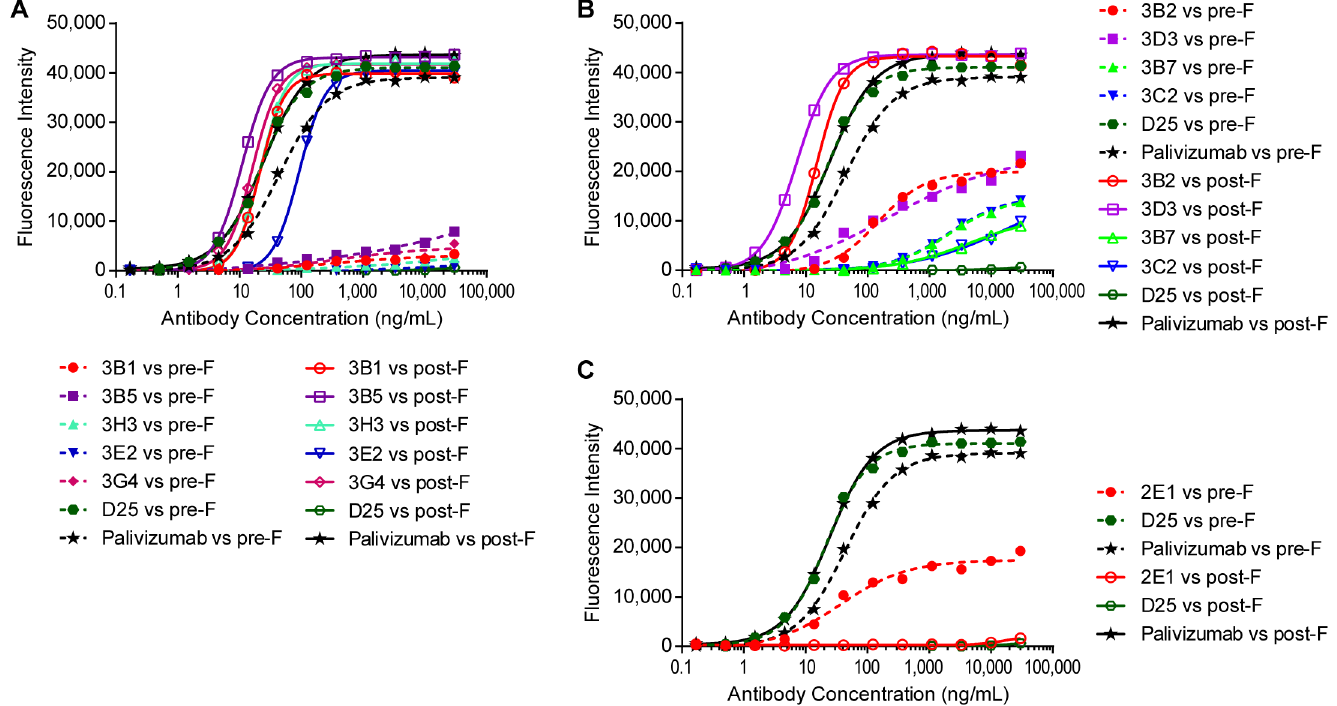
Fig 1. Anti-RSV F antibodies identified from Morphosys HuCAL GOLD 1 phage display libraries. Heavy chain C-terminal 6xHis tagged antigen specific bivalent Fabs were purified with Ni-NTA column and then tested in ELISA binding to RSV prefusion and postfusion F proteins. (A) Antibodies preferentially binding to RSV postfusion F protein; (B) Antibodies binding to both RSV postfusion and prefusion F proteins; (C) antibody binding specifically to RSV prefusion F protein. Full-length human IgG1 D25 (prefusion F specific) and palivizumab (binding to both prefusion and postfusion F) were used as control antibodies in the above